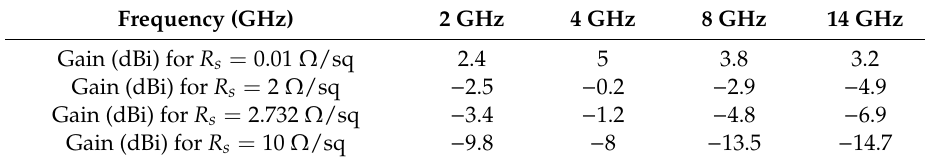
Figure 7. The E plane and H plane radiation patterns of the proposed antenna at 4 GHz when optimizing the sheet resistance R s of conductive layer. Table 1. Gains at di ff erent sheet resistances under various